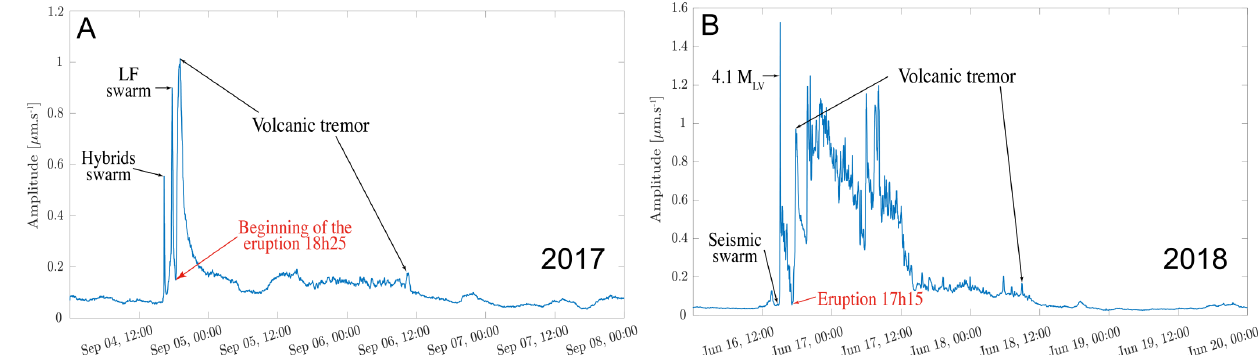
Figure 1: Median Seismic Amplitude data in 10-minute windows during two Fernandina volcano eruptions. Traces are corrected for instrument response and filtered between 1 – 8 Hz.: [A] 2017, seismic station nearest FER2 and [B] 2018, seismic station nearest FER1. See Figure 2 for the location of the seismic stations.